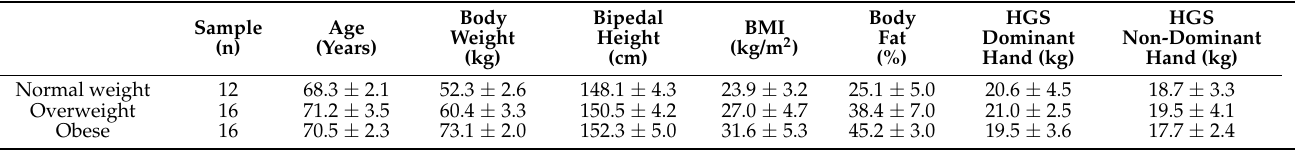
Table 1. Baseline characteristics of the sample.